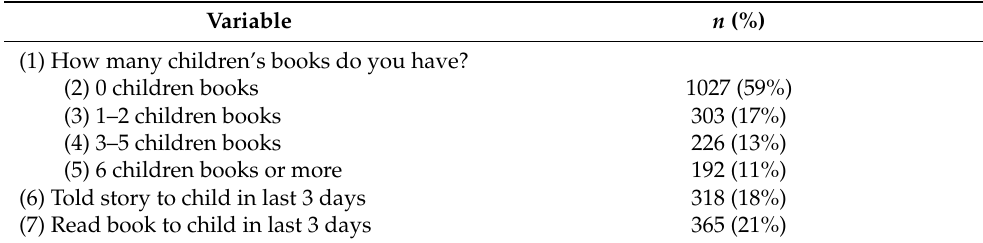
Table 2. Book ownership and reading behavior among caregivers ( n = 1748). Variable